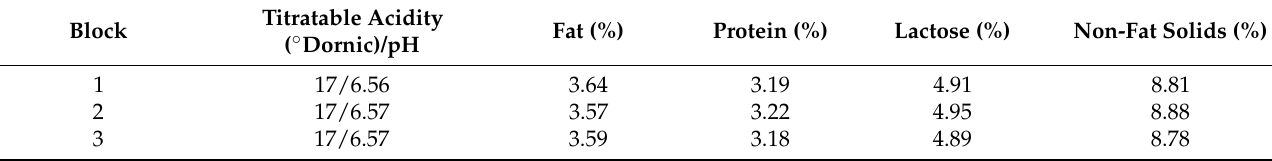
Table 1. Physicochemical parameters of fresh raw milk prior to ultrasound